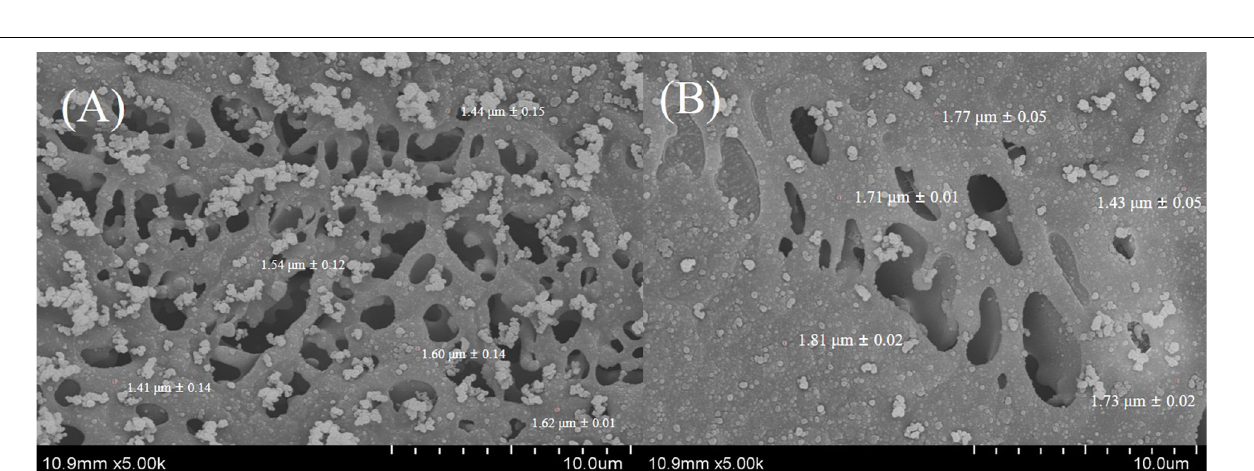
Frontiers in Nutrition |